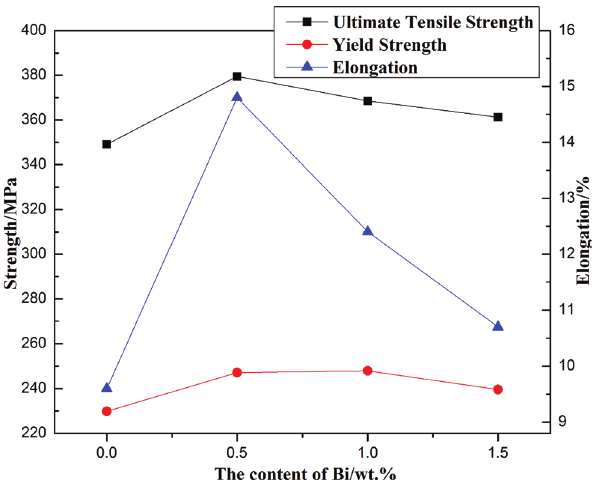
Figure 6: Tensile properties of the as-extruded AZ80 – 2Sn alloys with different Bi additions tested at room